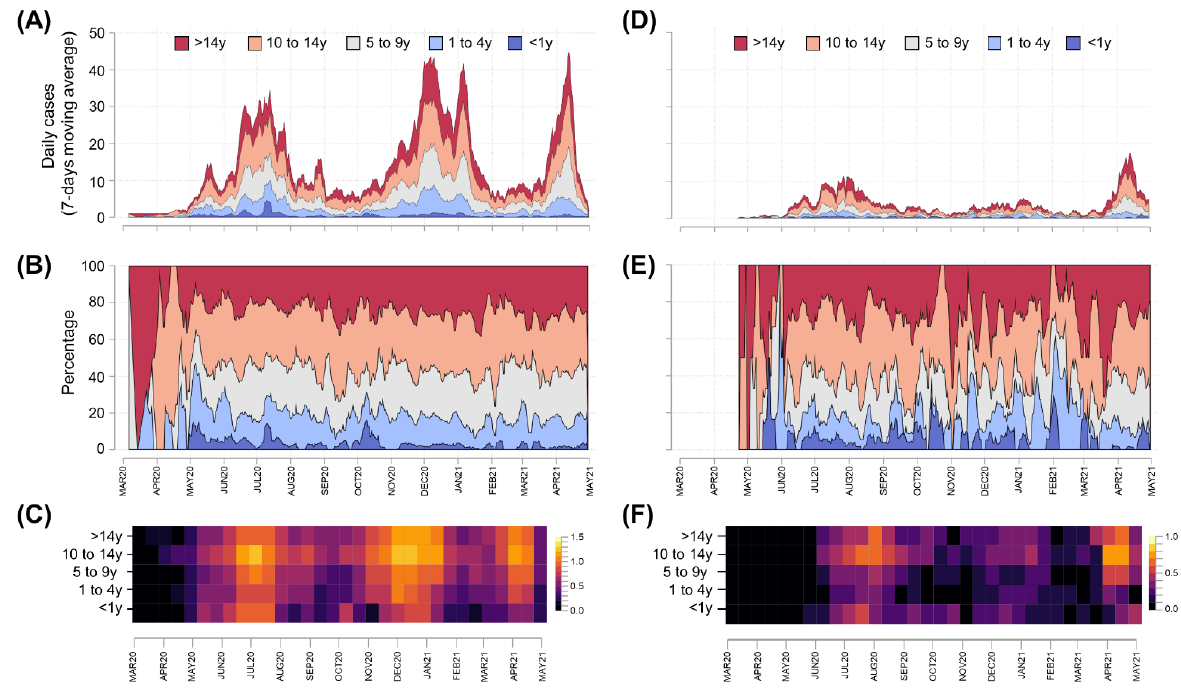
Figure 3. Age-stratified epidemic curves for Bolívar and Cartagena, as of 31 April 2021. Daily confirmed new cases were presented using epidemic curves (panels ( A , D )) and stacked area plots (panels ( B , E )) on linear scales, while cases per 100,000 population were presented using heat maps (panels ( C , F )) with log (x + 1) scales to improve readability. Data for Cartagena (panels ( A – C )) and other municipalities of Bolívar (panels ( D – F )) were presented using symptom onset dates and 7-day moving averages.